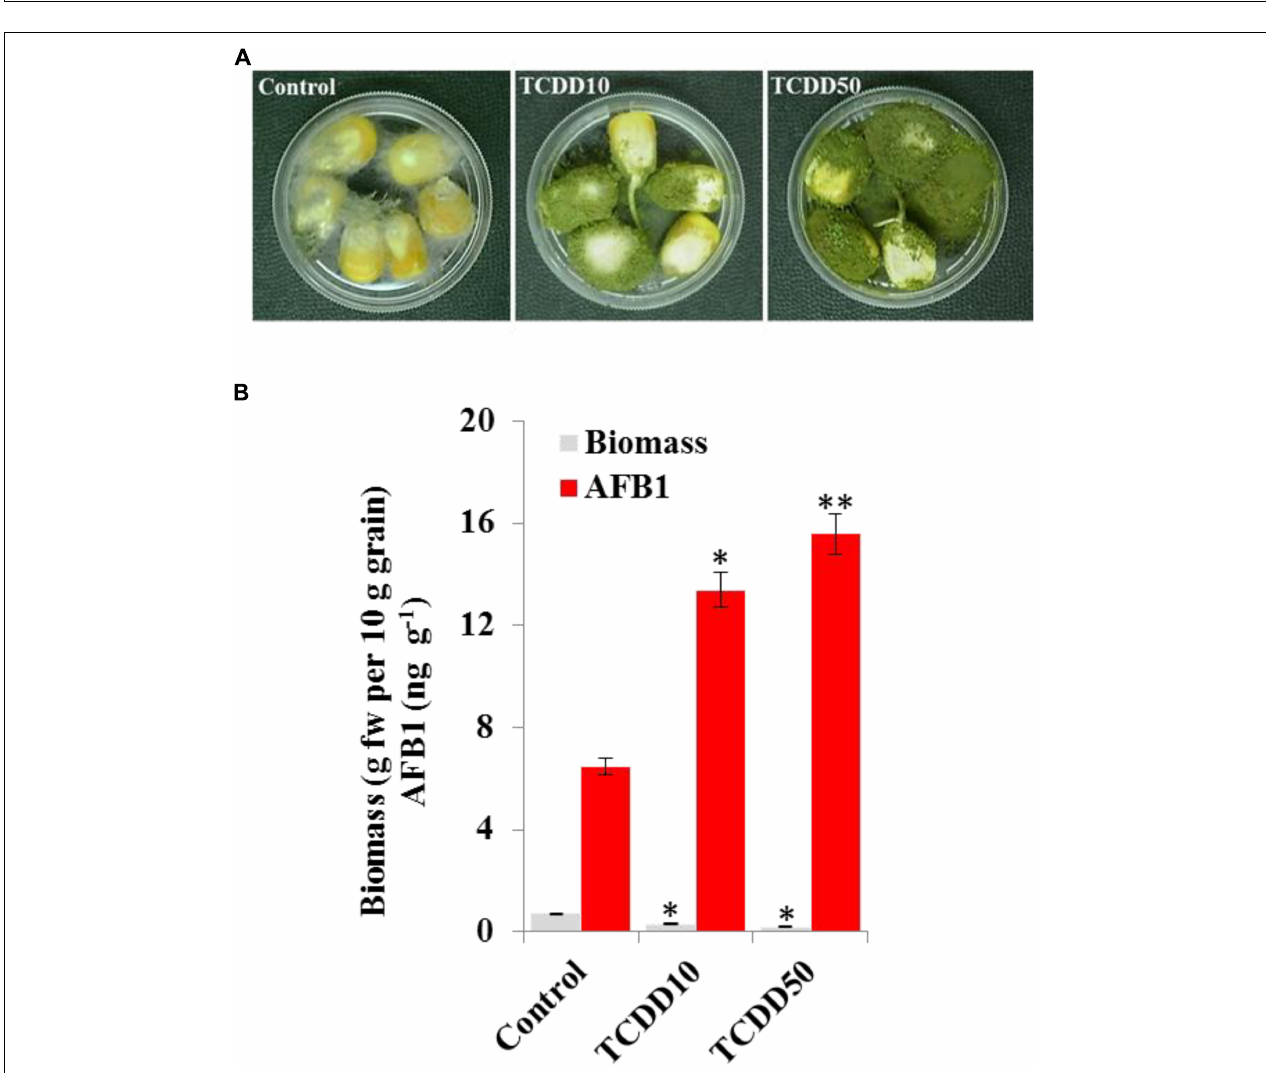
FIGURE 5 | The exposure to TCDD boosts the aggressivity of A. flavus against the maize grains. (A) Photographs of infected maize grains with A. flavus previously exposed to TCDD at 10 and 50 ng L − 1 referred to as TCDD10 and TCDD50, respectively, compared with non-exposed fungus control. After sterilizing, grains were placed in a sterile petri plate and directly inoculated with 200 µ l of liquid culture of A. flavus in PD broth contaminated or not contaminated with TCDD. The photographs were taken 8 days after inoculation. (B) Estimation of fungal biomass and AFB1 production in the three samples. Asterisks indicate significant differences between treatments and control ( ∗ P < 0.05; ∗∗ P <